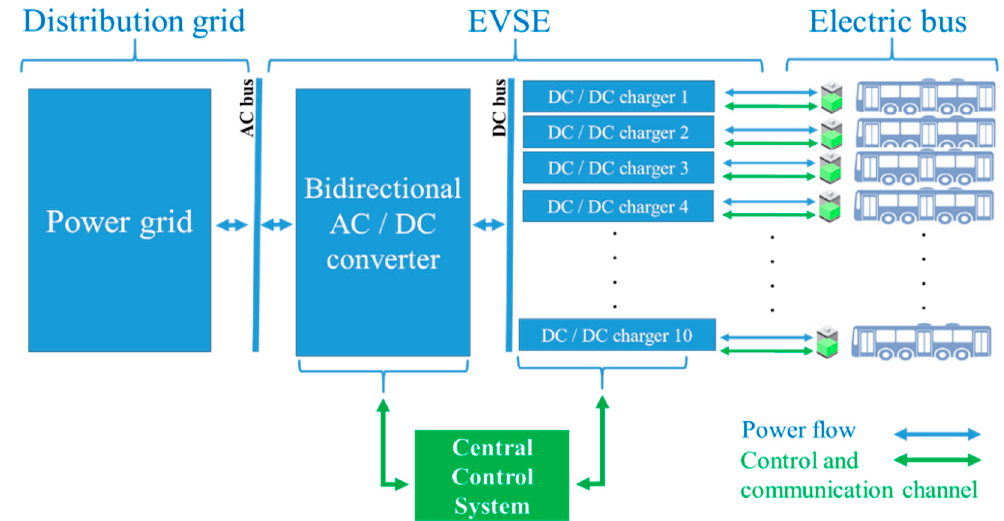
Figure 6. Charging Figure 6. Charging infrastructure.